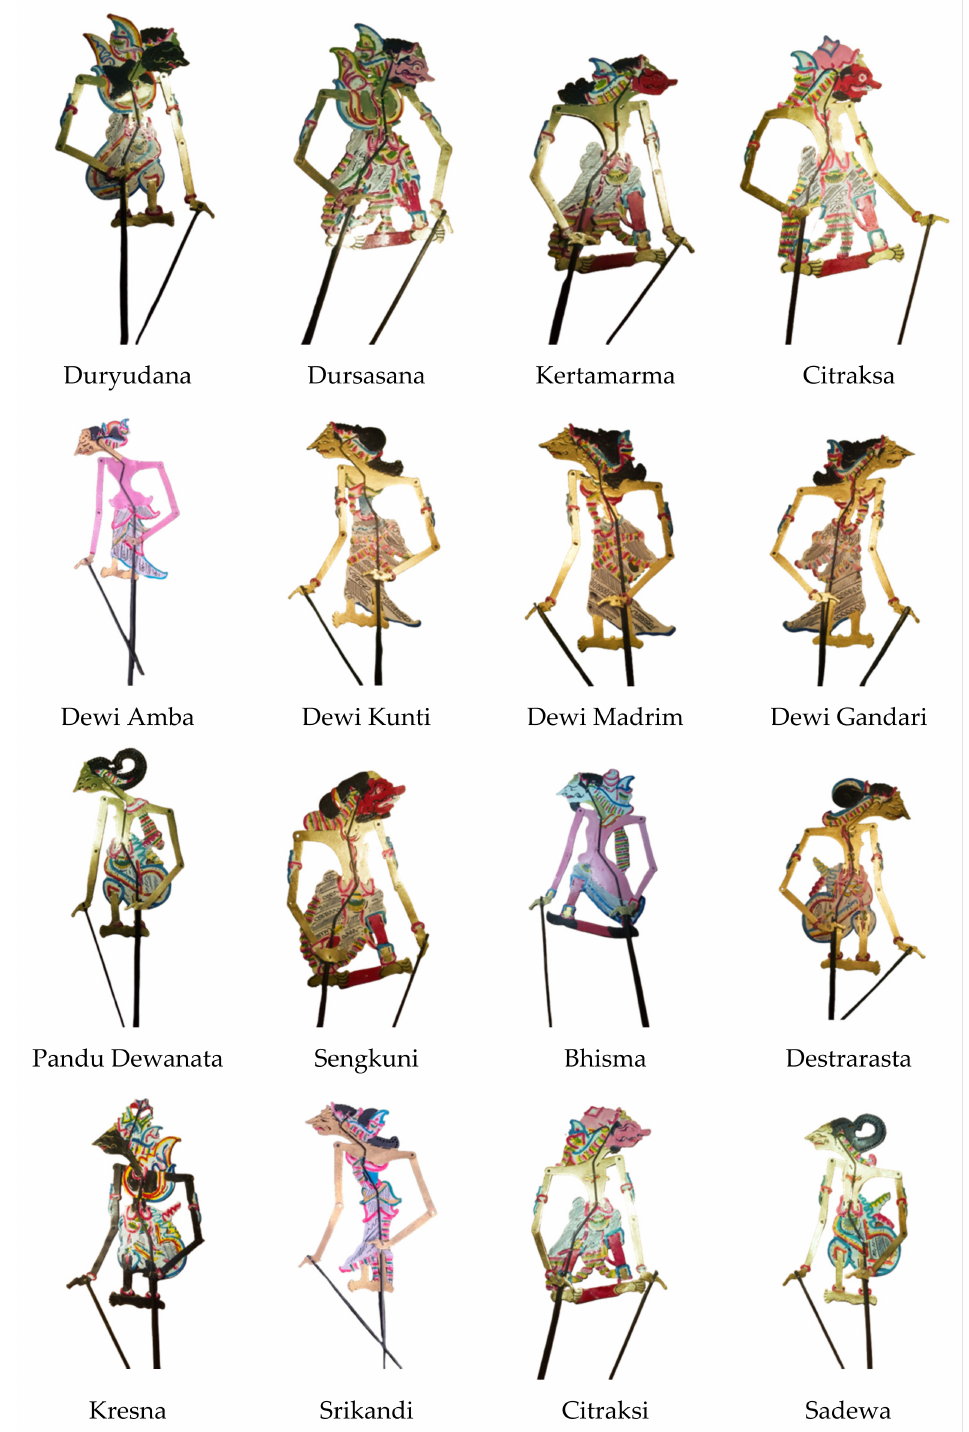
Figure 5. The puppet of main characters in Mahabharata story. In the arrangement of characters on the kelir screen, the left side consists of puppets with bad characters, and the right side consists of puppets with good characters. Whether or not it is consciously arranged, a puppeteer has used the concept of the sets to arrange the puppet characters on the screen during the shadow puppet show. It is defined as a clearly defined collection of objects [48,49]. With the methods and ideas of the Javanese people themselves, they have collected objects in the arrangement of characters on the screen, which they have clearly